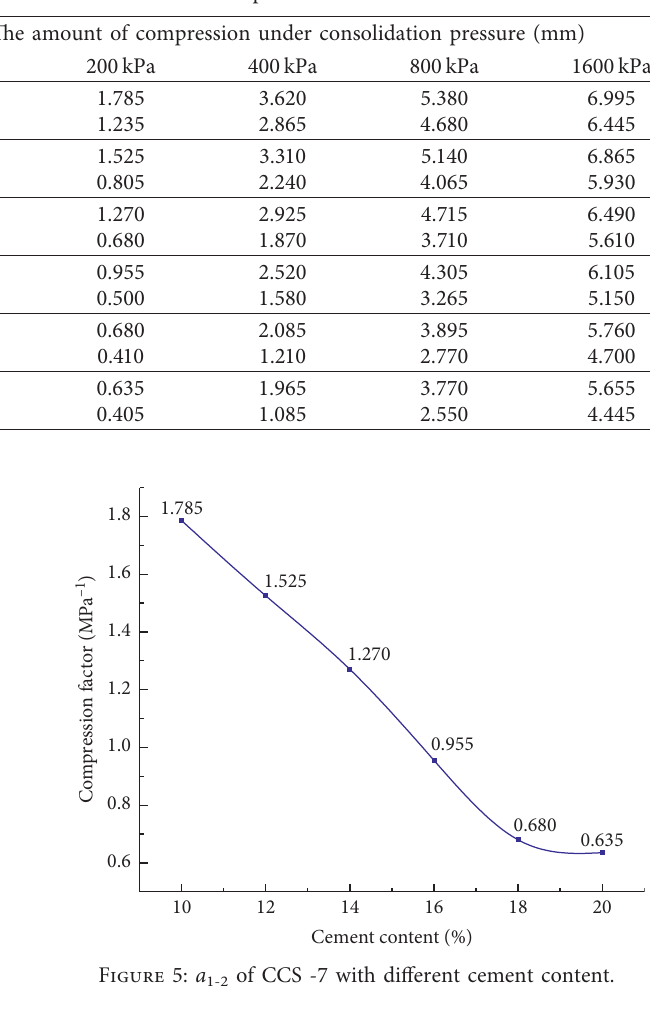
Figure 4: Change in the void ratio of CCS.